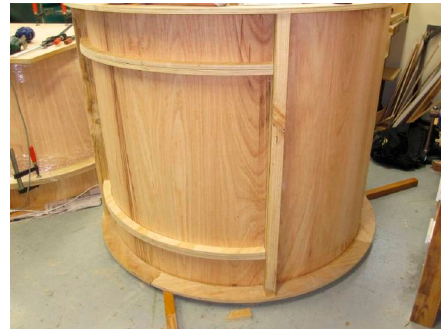
Figure 4. 75 × 38 mm pine lengths used for reinforcement and framing.